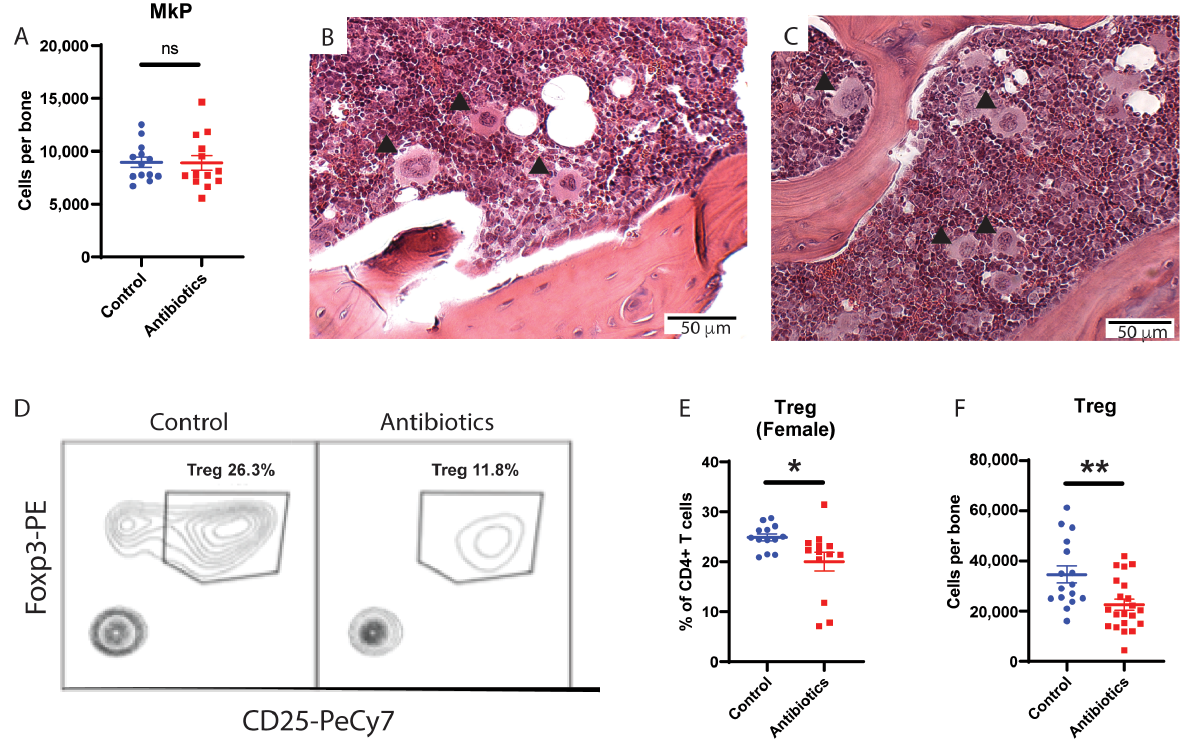
Figure 2. Antibiotic administration does not change megakaryocyte progenitors (MkP) but leads to decrease in regulatory T cells (Treg) in bone marrow. ( A ) MkP population from whole bone marrow (WBM) for control vs antibiotic-treated (antibiotics) are shown using flow cytometry. MkP (solid arrows) size, shape and number from bone marrow are compared between ( B ) control and ( C ) antibiotics (hematoxylin and eosin staining of bone marrow from femur, 10 × ). ( D ) Flow cytometry plot of Treg population comparing control and antibiotics-treated group. ( E ) Treg population from WBM of female mice for control vs antibiotics. ( F ) Number of Treg per tibia for male and female control vs antibiotics-treated mice are shown. Results are compiled from 2–3 independent experiments ( n = 5–8 per experiment). Graphs show mean + SEM. Graphs show mean + SEM. Statistical significance was determined by Mann-Whitney U test. ns, not significant, * p < 0.05, ** p <